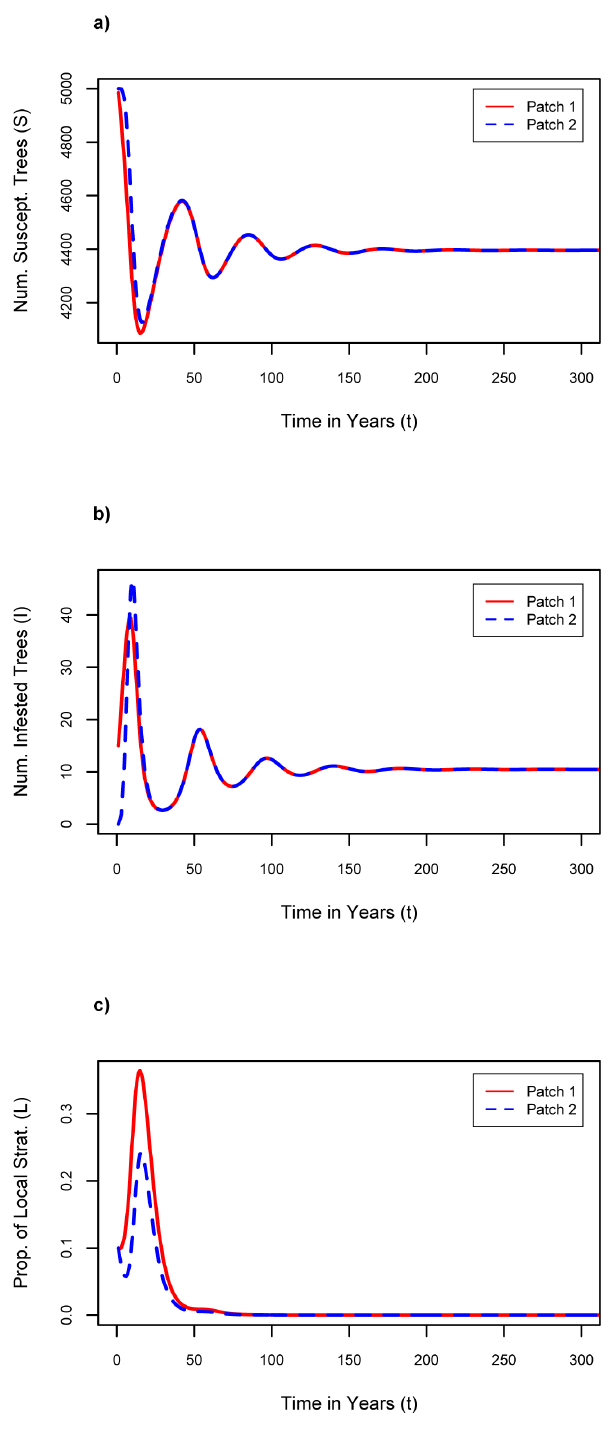
Figure 1. Results of baseline. Baseline: n=0.1, f=0.1, s =0.1, Cl= $ 6.75 where a) number of susceptible trees as a function of time; b) number of infested trees as a function of time; c) proportion of local firewood strategists as a function of time. doi:10.1371/journal.pone.0090511.g001 (Fig. 4d–f). There are two sharp thresholds in these plots: when f # 0.17, strong cross-patch infestation occurs, the pest becomes endemic, and all individuals are local strategists, as in the baseline scenario; when 0.17 , f , 0.3113, moderate crosspatch infestation